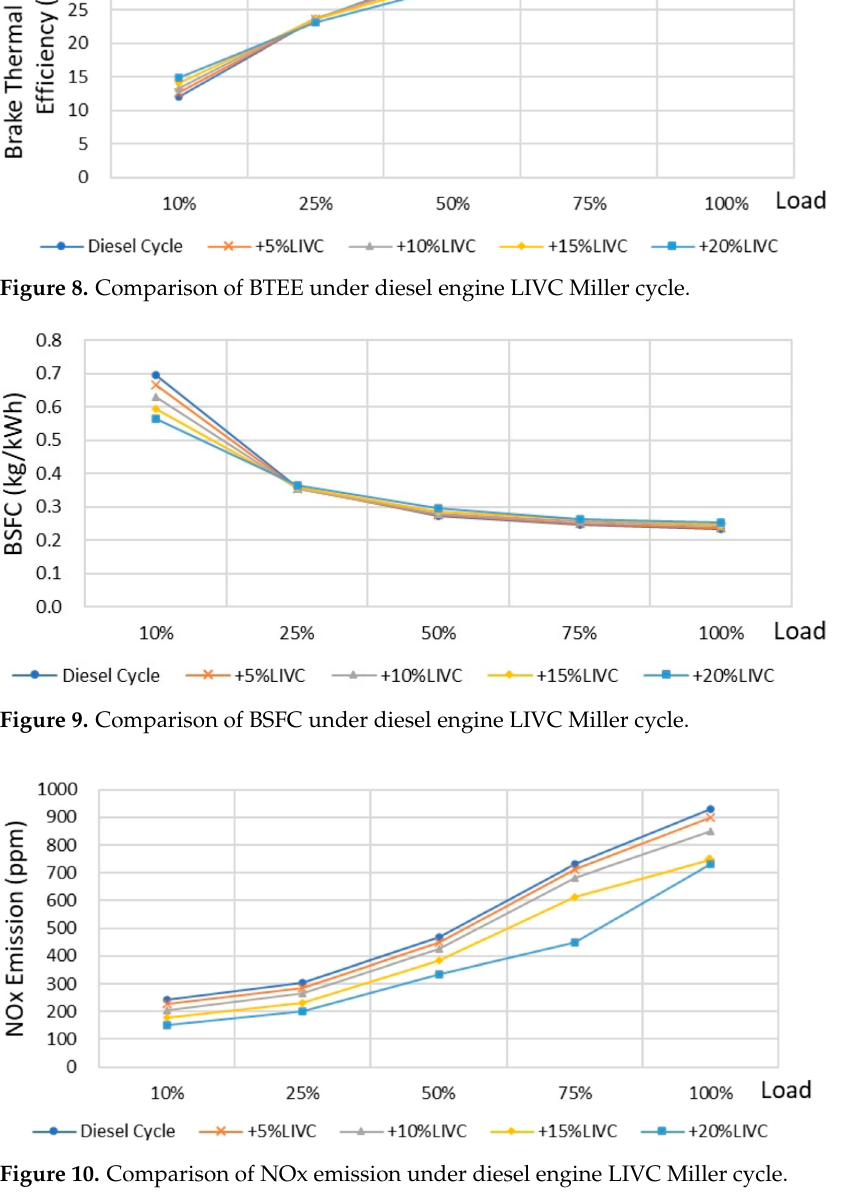
Figure 10. Comparison of NOx emission under diesel engine LIVC Miller cycle.